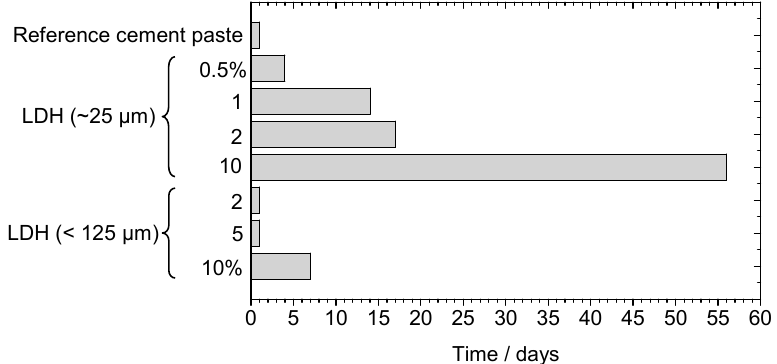
Figure 6. Influence of LDH particle size on the curing time of cement paste (% of LDH with respect to the mass of cement).